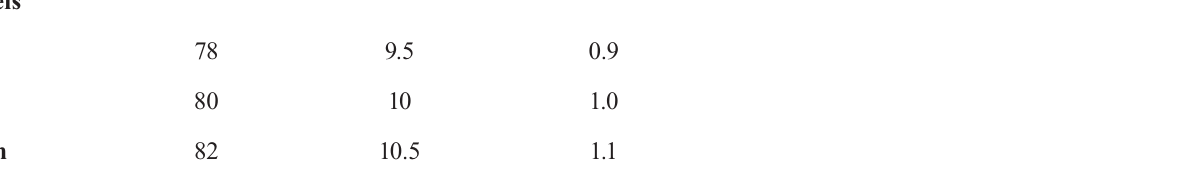
Where A= Methanol (%), B= Strength of TBAHS (mM) and C= Flow rate (mL.min -1